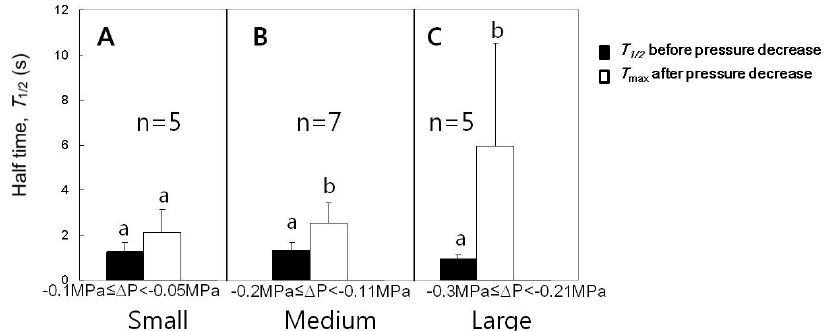
Figure 6. Effects of the decreased cell turgor pressure on the maximum T ( T max ) for cells with T of approximately 1 s. ( A ) The decreases in the turgor by small ranges did not affect T . ( B ) The decreases in the turgor by medium ranges increased T . ( C ) The decreases in the turgor pressure by large ranges increased T in a bigger fold than in ( B ). Mean values ± SD were plotted. The significance in differences was tested and noted with different alphabets (n = 5–7 cells, paired t -tests for each range of turgor pressure decrease, p < 0.05).